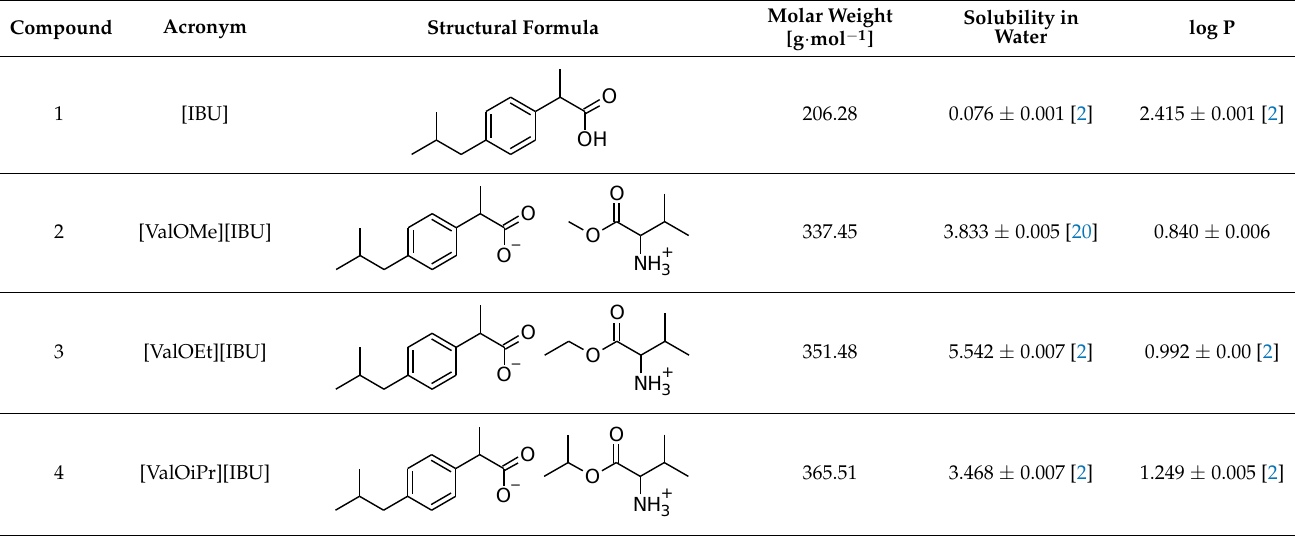
Table 1. The structural formula of ibuprofen and its derivatives.